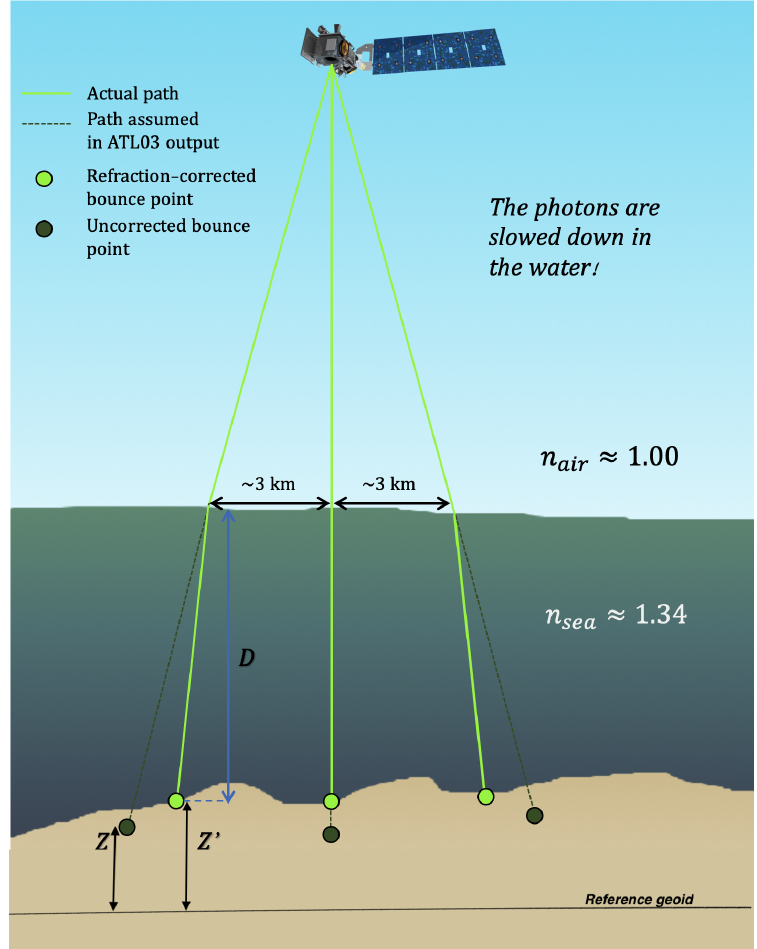
Figure 4. Illustration of refraction of the laser beams at the air-sea interface. Inspiration from [8]. In [8] an approximation to the refraction correction for the vertical offset is introduced as Z (cid:48) = Z + 0.25416 D , where Z (cid:48) is the corrected photon height, Z are the original height measurements and D is the absolute depth from water surface to seafloor (see Figure 4).